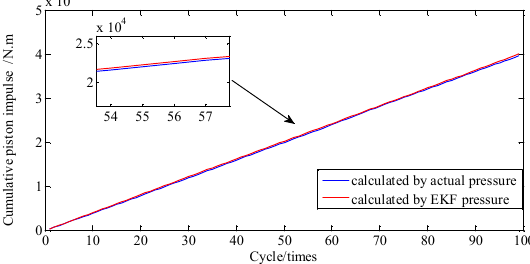
Figure 8. Pressure identification at A/F ratio 0.85.